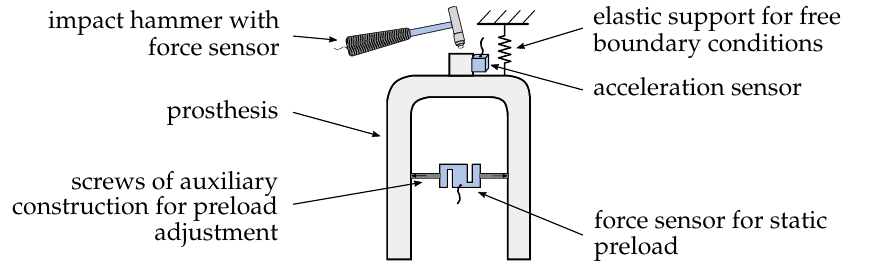
Figure 1. Representation of the used test setup with sensor locations, support and auxiliary construction.